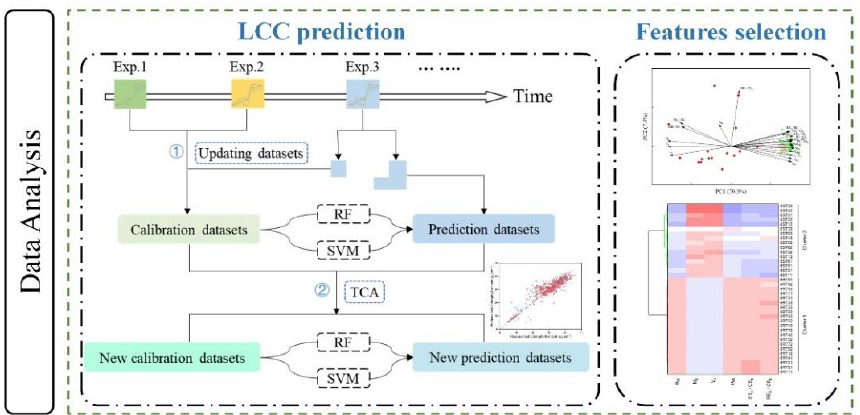
Figure 1. Flowchart of maize phenotype monitoring. Three individual experiments (Experiments 1 – 3) were conducted in the same greenhouse in August, November, and December 2021, respectively. GR: glyphosate-resistant cultivar; GS: glyphosate-sensitive cultivar; DAT: days after treatment; HSI: hyperspectral image; ChlF: chlorophyll a fluorescence; LCC: leaf chlorophyll content; RT, RW, ST, and SW: “R” stands for “glyphosate - resistant”, “S” stands for “glyphosate - sensitive”, “T” stands for “with glyphosate”, and “W” stands for “with water”; RF: random forest; SVM: support vector machine; TCA: transfer component analysis.